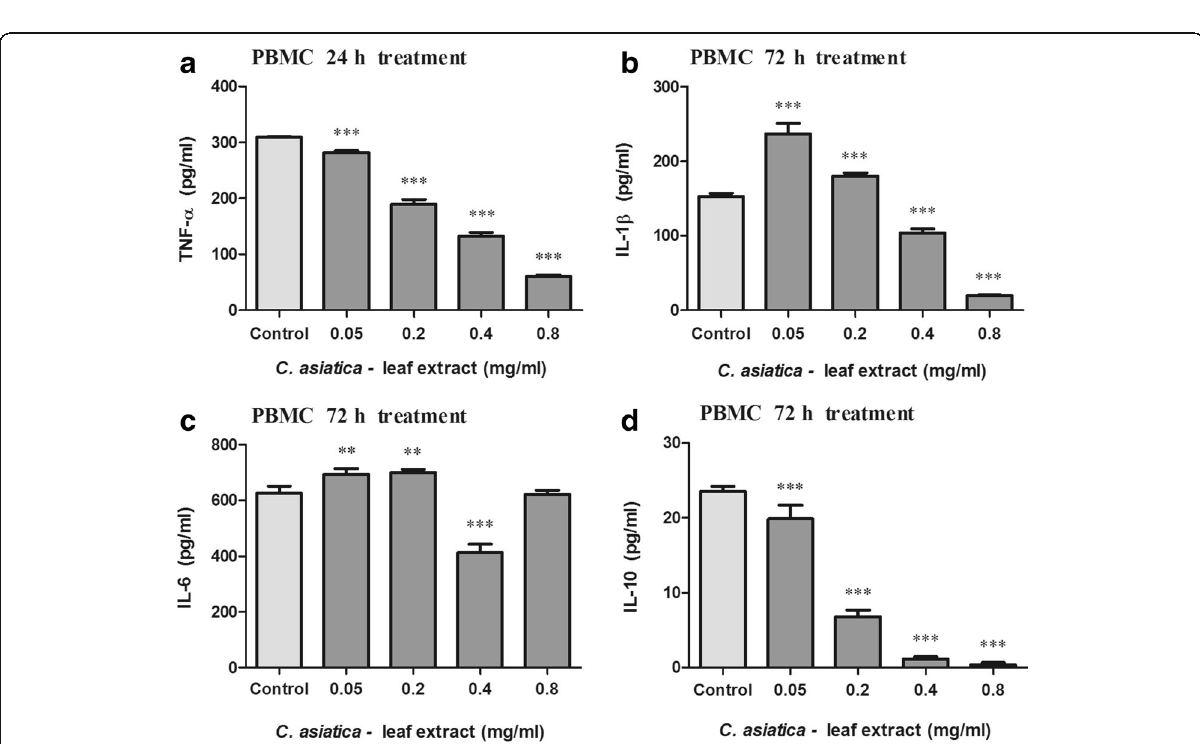
Fig. 3 Concentration of TNF- α ( a ), IL-1 β ( b ), IL-6 ( c ) and IL-10 ( d ) in C LE treated PBMC ’ s (Values expressed as mean ± SD, * p < 0.01, *** p < 0.0001, compared to the